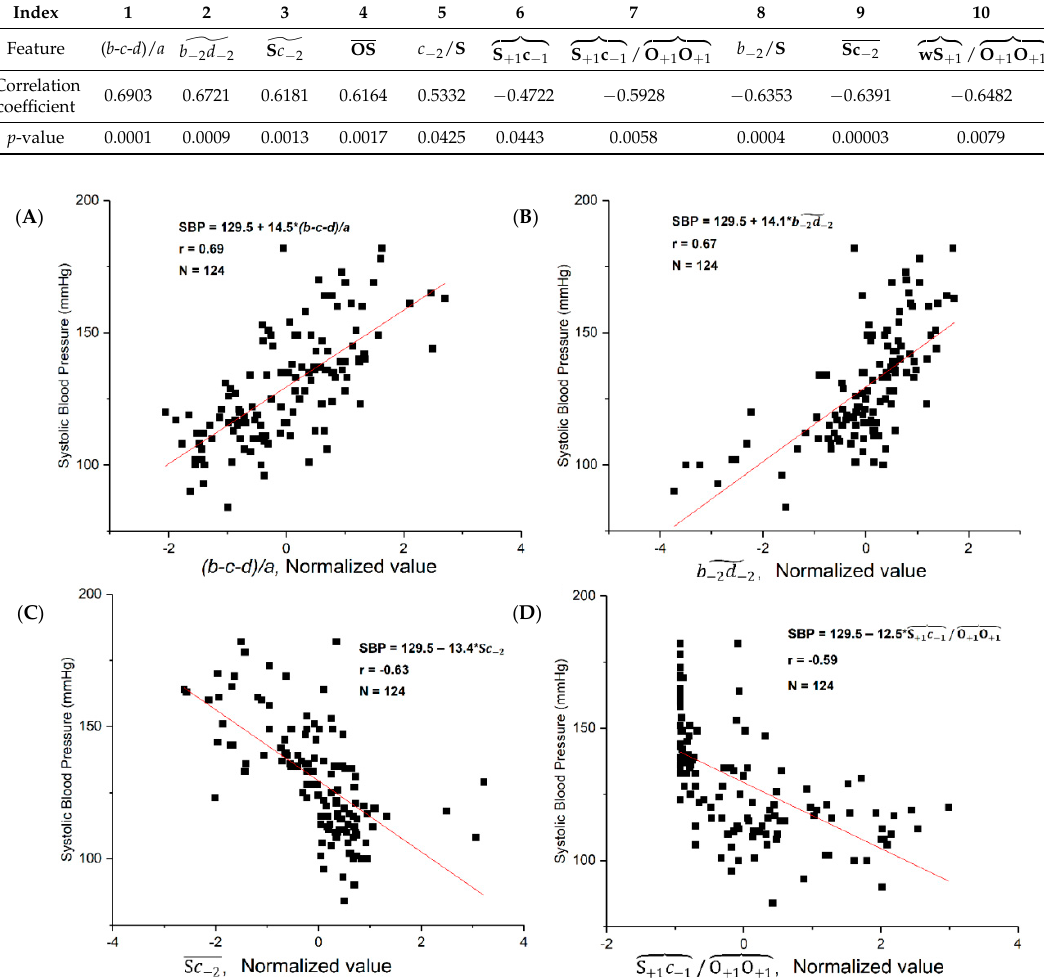
(cid:94) (cid:93) (cid:3563) (C) 𝐒𝒄 (cid:3563) (D) 𝐎𝐒 . (cid:2879)𝟐 𝒅 (cid:2879)𝟐 (cid:2879)𝟐 b − 2 d − 2 ( C ) S c − 2 ( D ) OS